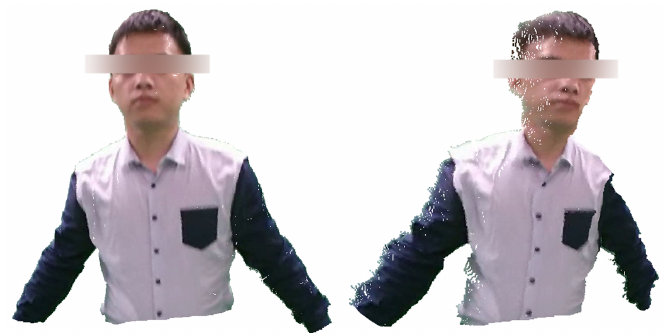
Figure 6. Dense reconstruction of seven body